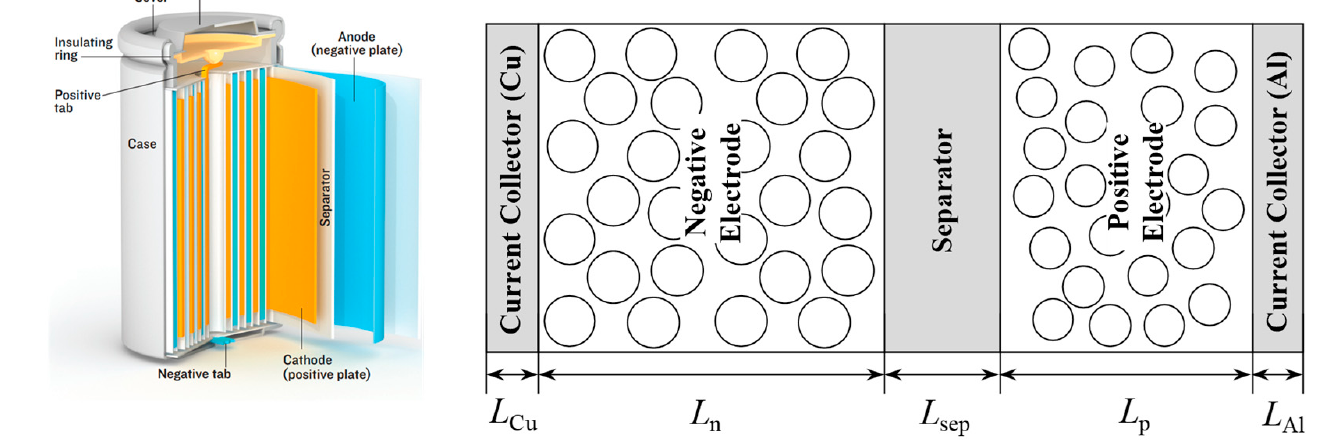
Figure 1. Intrinsic cell structure [22] and model calculation domain.